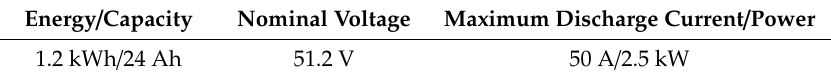
Table 2. Specification energy storage